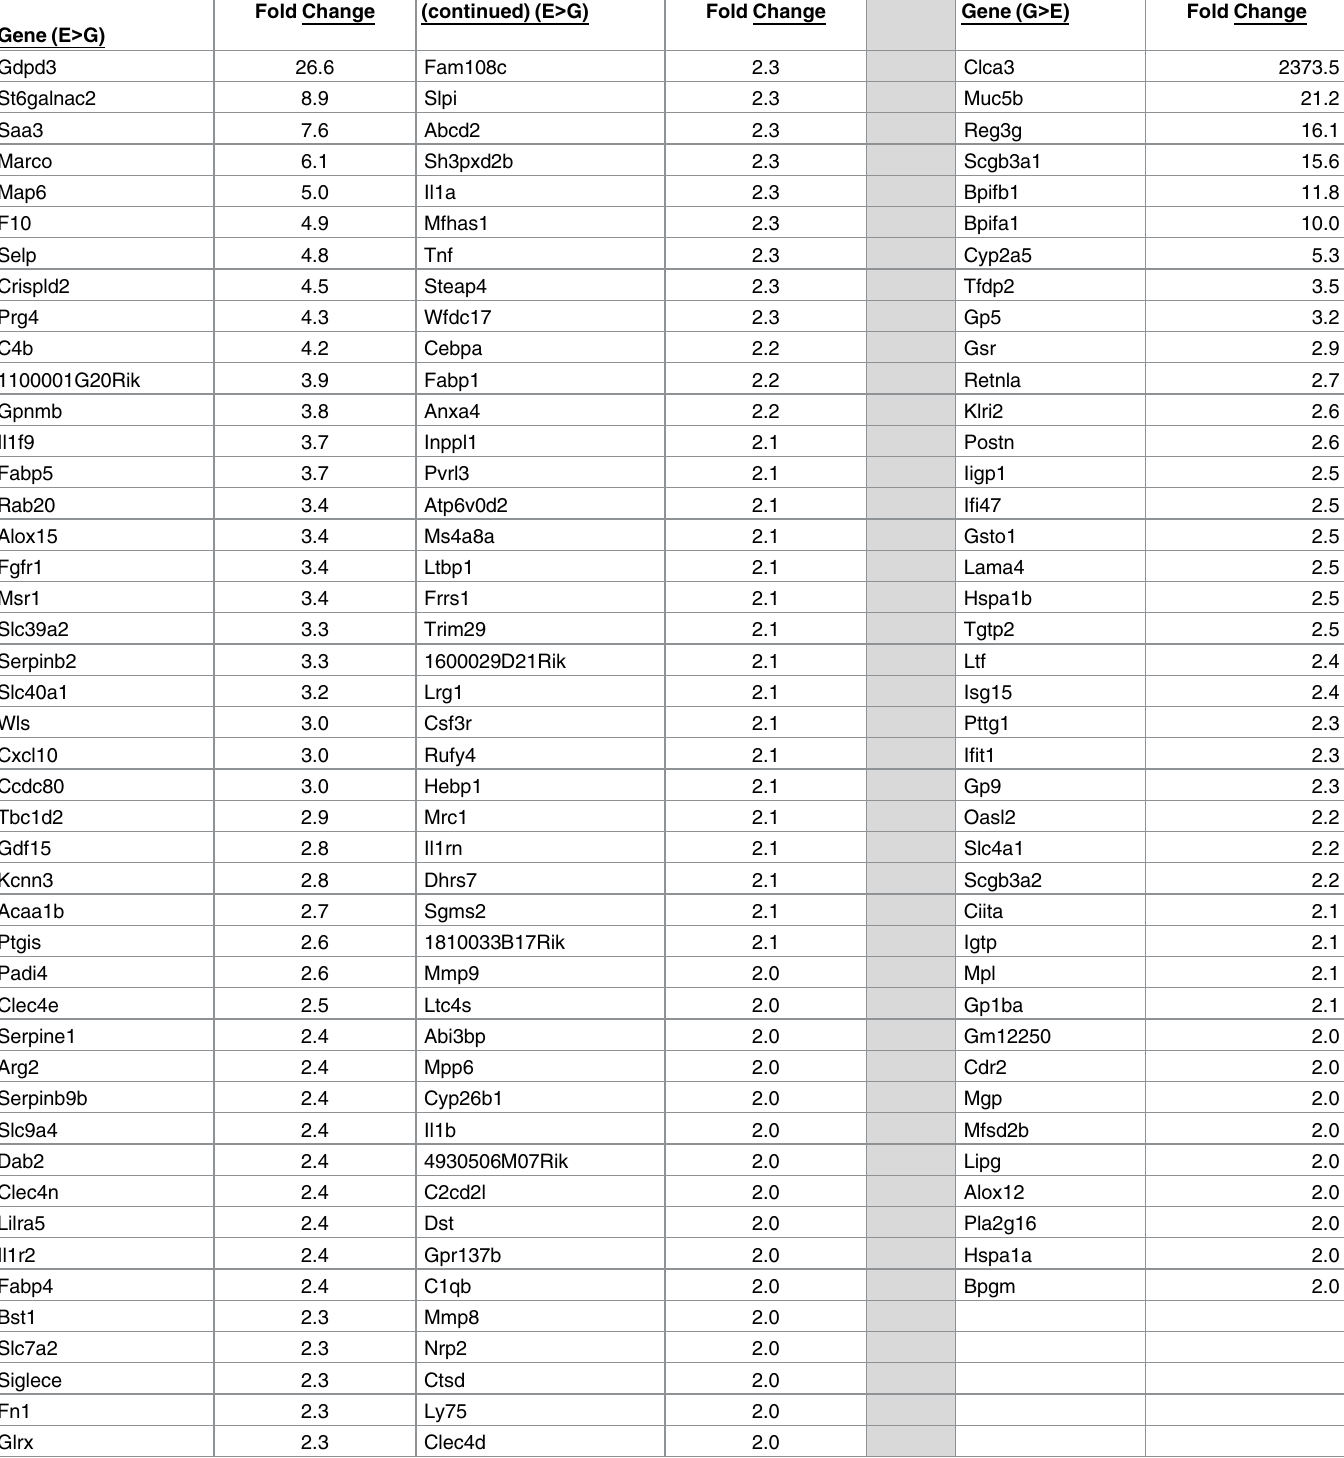
Table 1. Saline α 7 E260A:G versus α 7 G Response Difference(Gene Ratio >